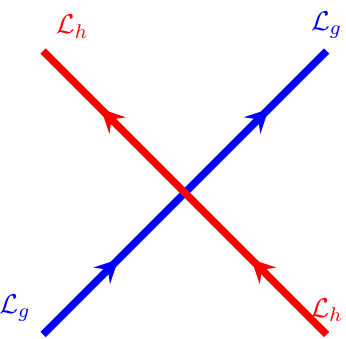
Figure 2 . The group G res is abelian. Thus, the fusion of any two defects L g and L h , g, h ∈ G res is commutative L = L , which means that L and L can simply ‘cross each other’. In this g L h h L g g h figure, the lines represent codimension 1 defects.